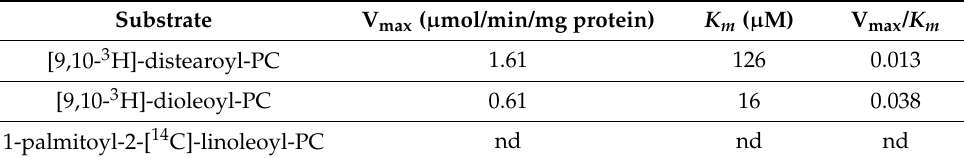
Table 1. Kinetic parameters of PLAAT1 with various substrates 1